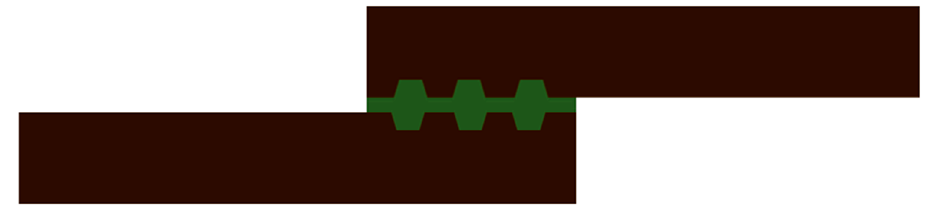
Figure 11. AM adherends with enhanced bonding area in the adherend volume [49].